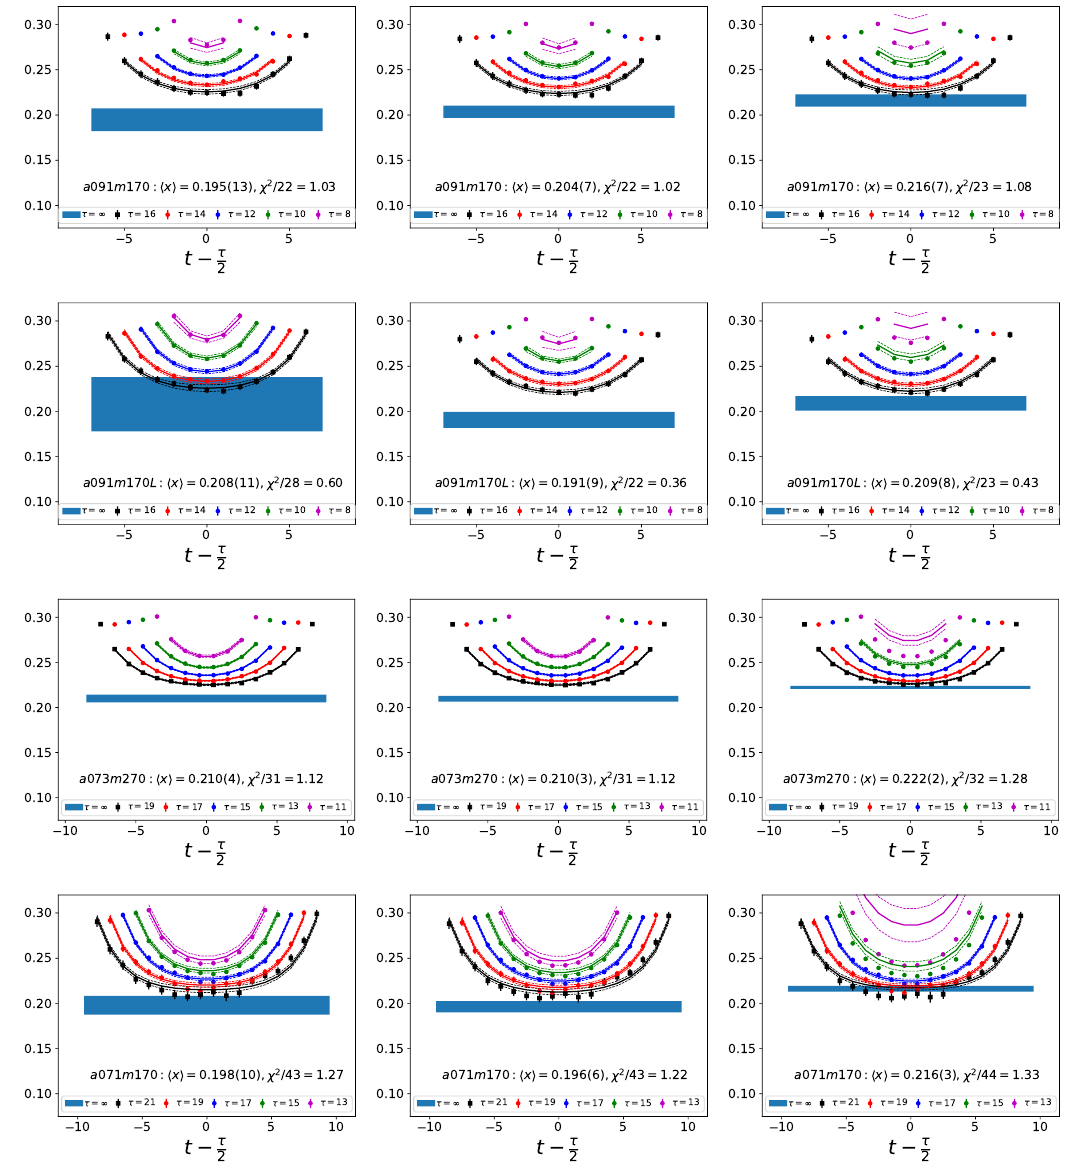
Figure 8 . Continuation of the data and fits to remove excited-state contamination in the extraction of the helicity moment h x i for a 091 m 170 (top row), a 091 m 170 L (second row), a 073 m 270 ∆ u − ∆ d (third row), and a 071 m 170 (bottom row). The data for the ratio C 3 pt ( τ ; t ) /C 2 pt ( τ ) is scaled using O eq. (3.9) to give h x i , and the fit parameters are listed in table 8. The rest is the same as in ∆ u − ∆ d figure